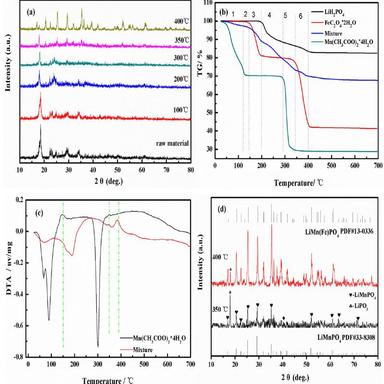
Schematic diagram of synthesis mechanism.